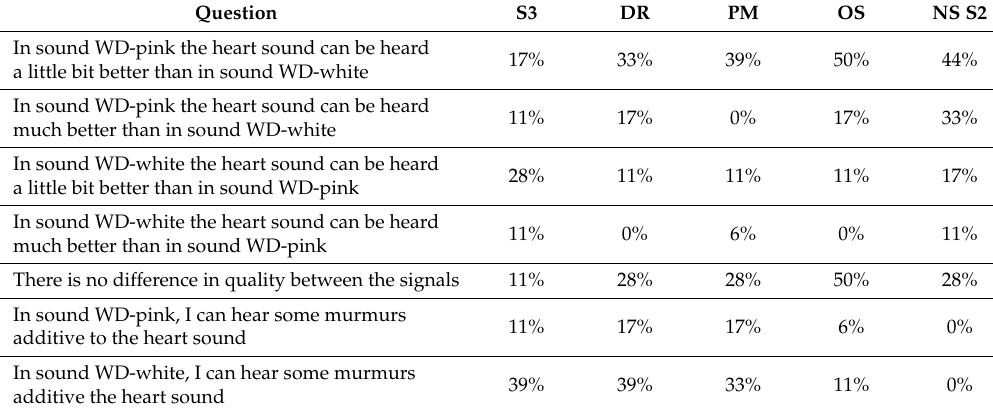
Table A3. Comparison of WD-pink with